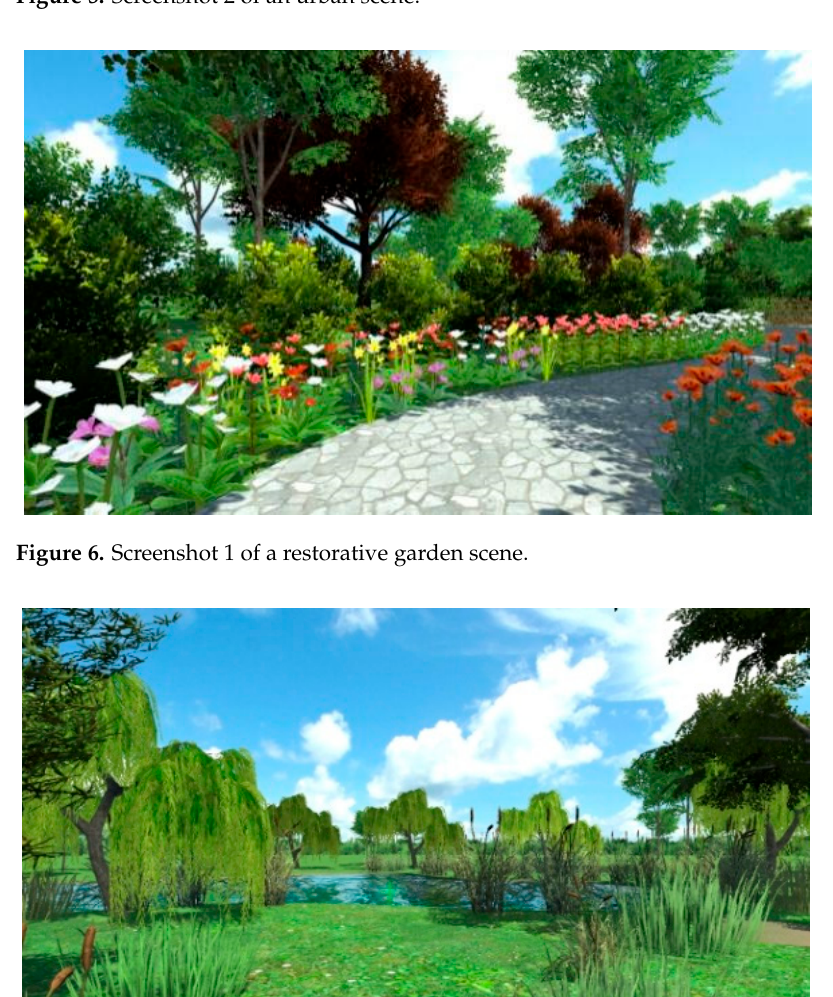
Figure 5. Screenshot 2 of an urban scene.